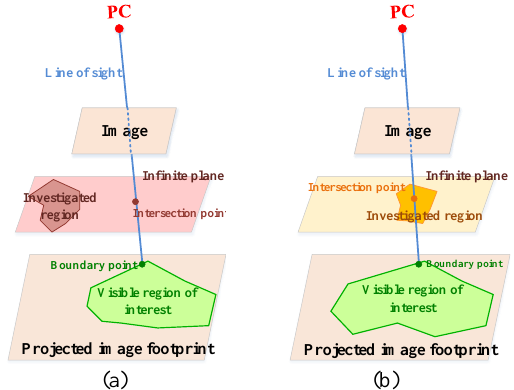
Figure 4. Visibility analysis of a planar region’s boundary point in a given image, (a) intersection point outside of region boundary (b) intersection point inside region